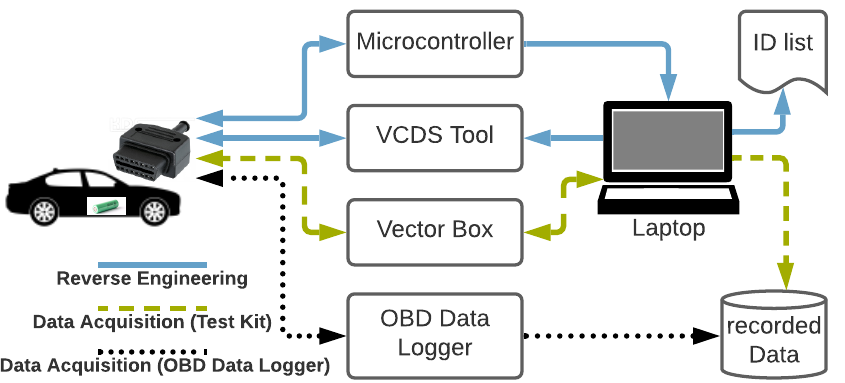
Figure 1. Setup for data acquisition (green: test kit, black OBD logger) and reverse engineering wiring